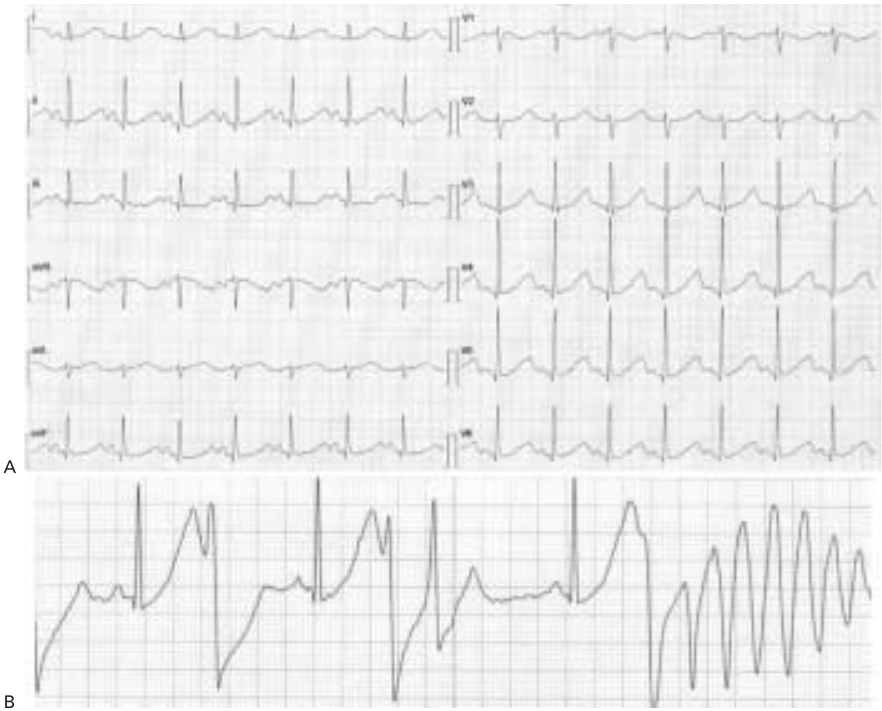
Methadone-induced QT-prolongation in the setting of severe hypokalaemia and after cocaine use, A Surface ECG dis- playing marked QT-U fusion (QT(U)c 663 ms; 25 mm/sec), B rhythm strip show- ing initiation of sustained TdP-VT (25